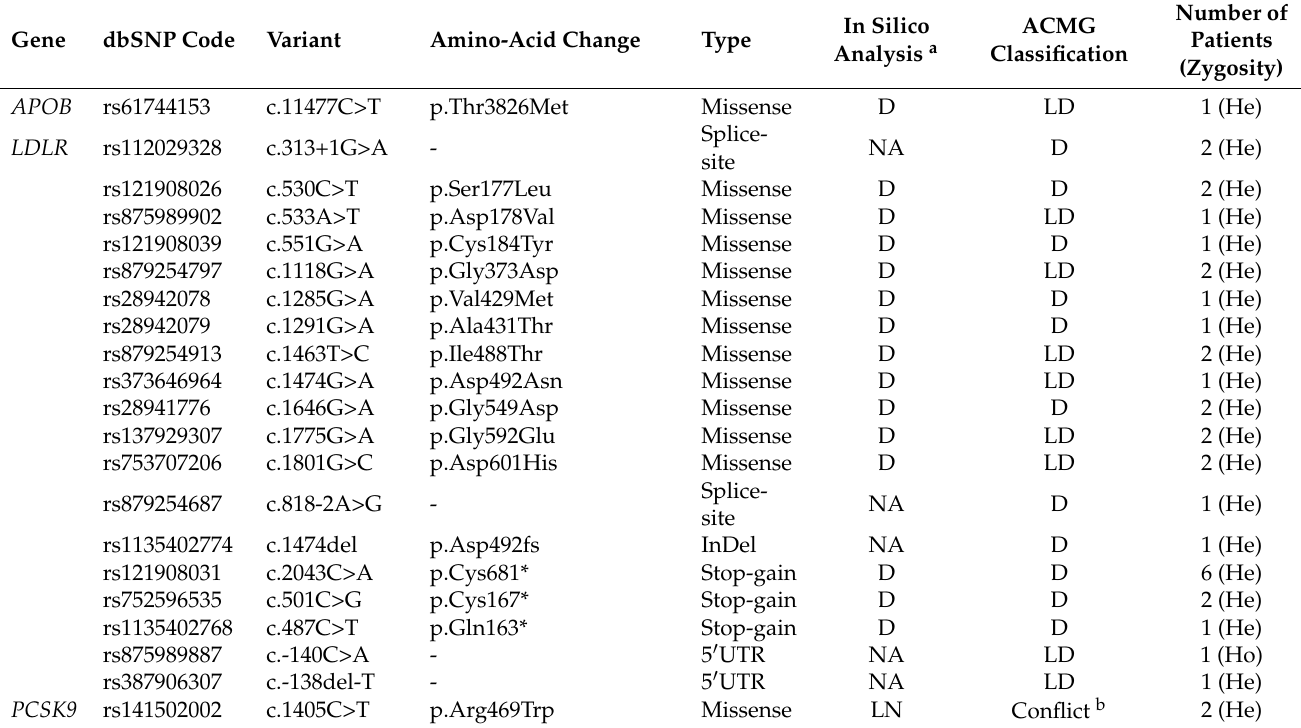
Table 2. FH-related pathogenic variants in FH patients ( n =